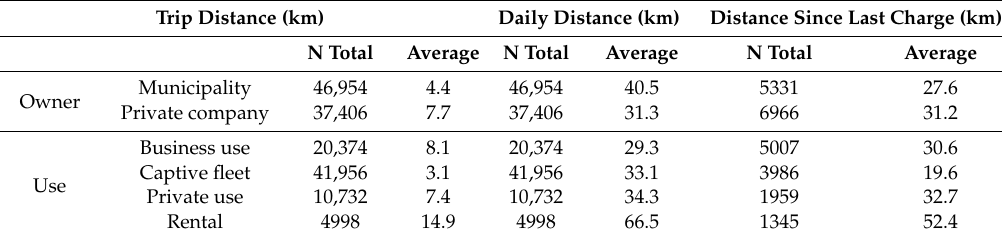
Table 1. Travelled distances [23].